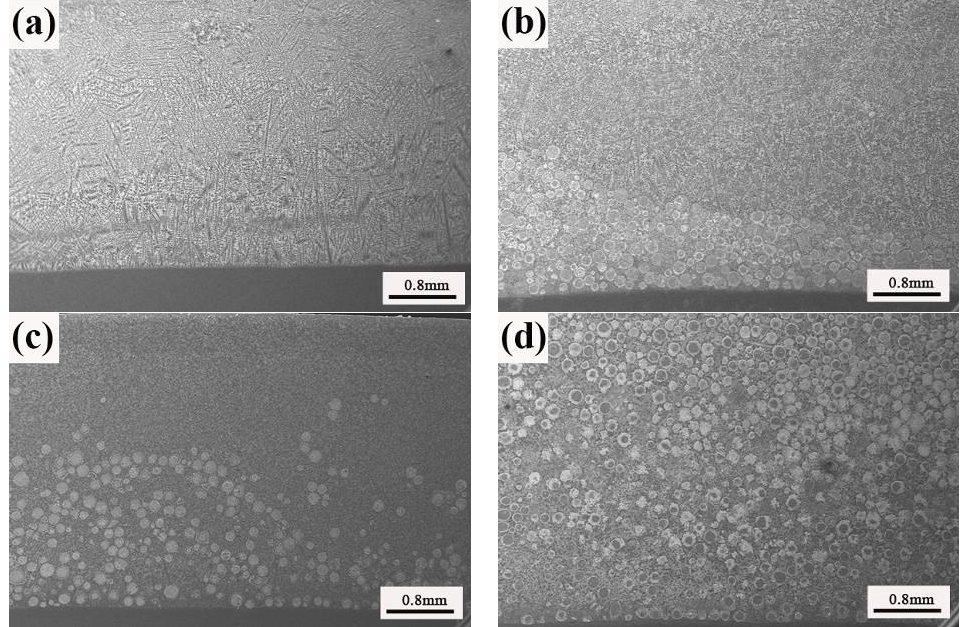
Figure 2. The SEM cross-section images of different samples ( a ) sample A; ( b ) sample B; ( c ) sample C; ( d ) sample